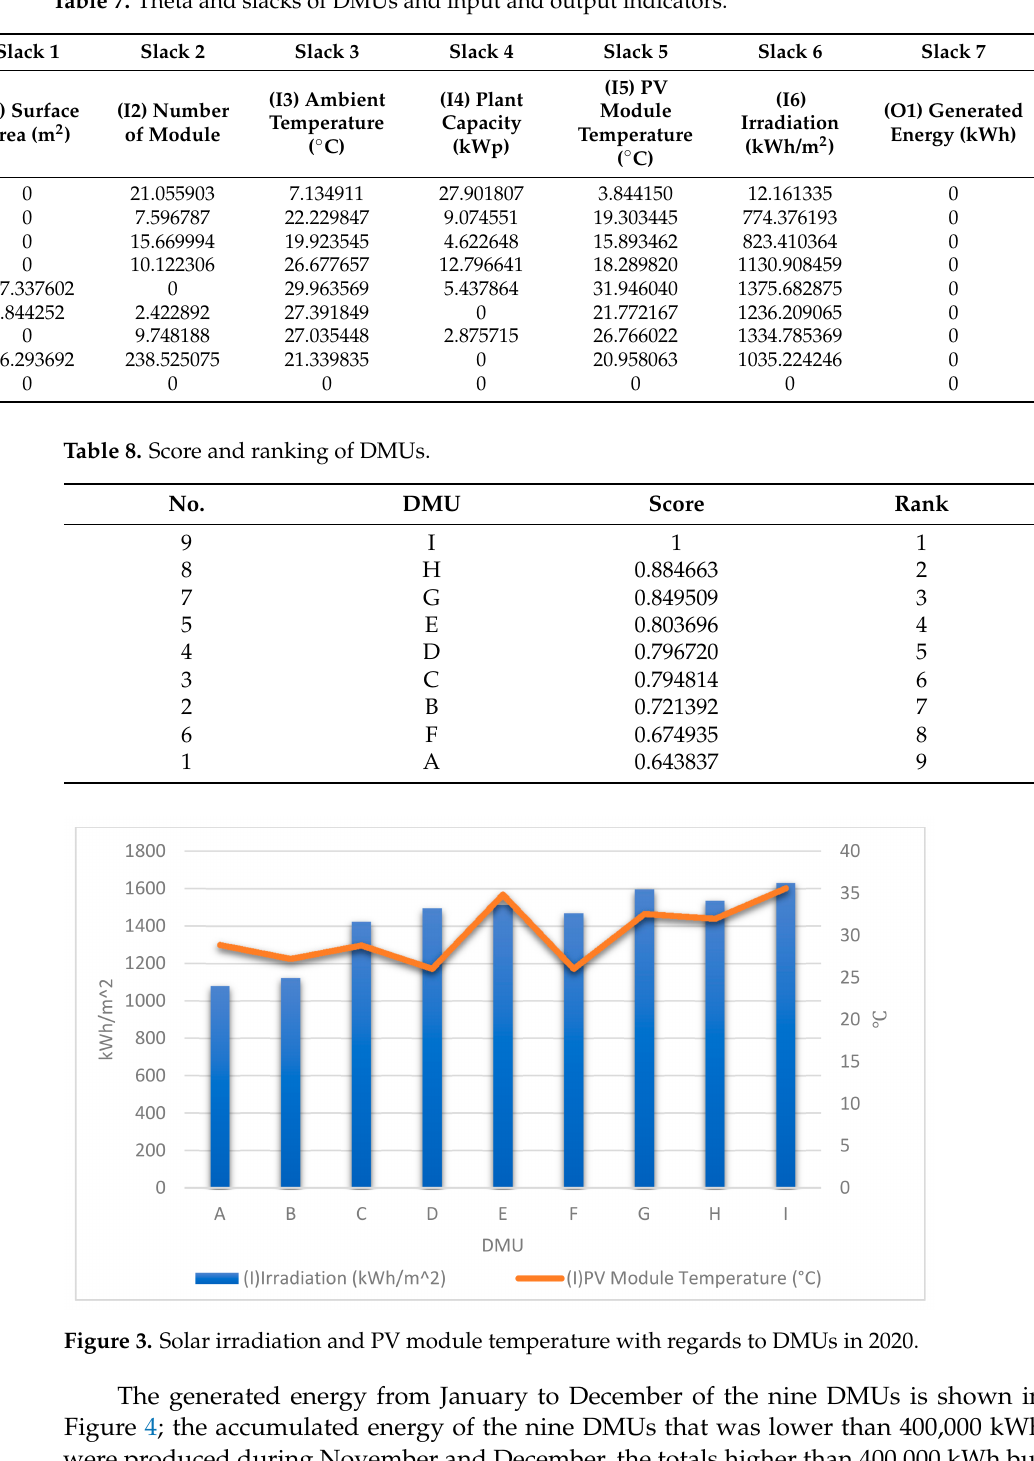
Table 7. Theta and slacks of DMUs and input and output indicators.